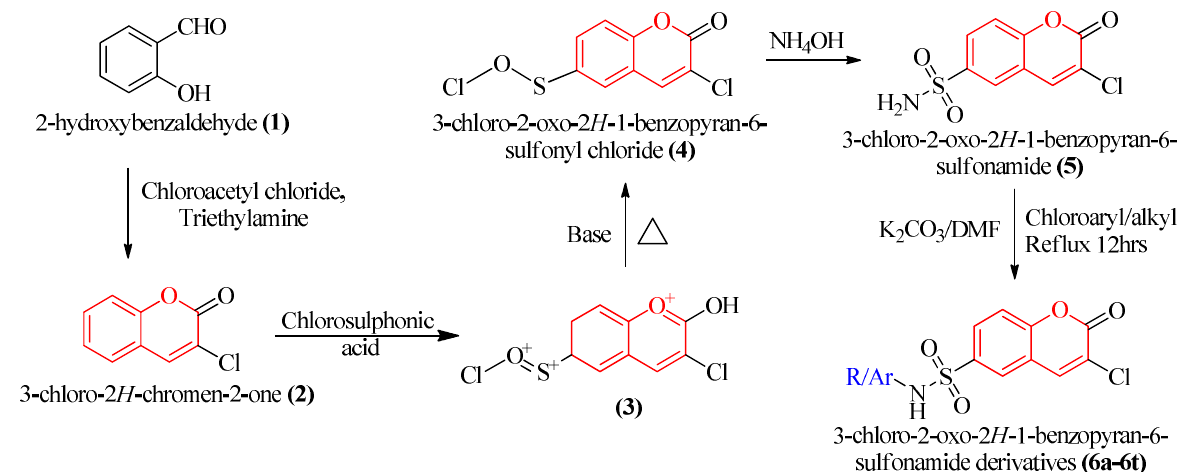
Figure 9. The detailed reaction pathway for the synthesis of coumarin-based sulphonamide derivatives.